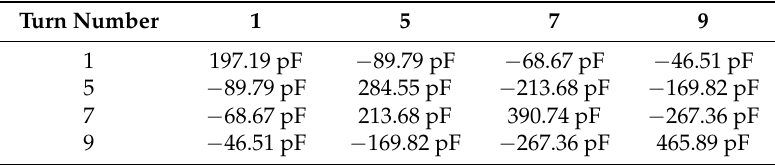
Table A2. A part of the capacitance